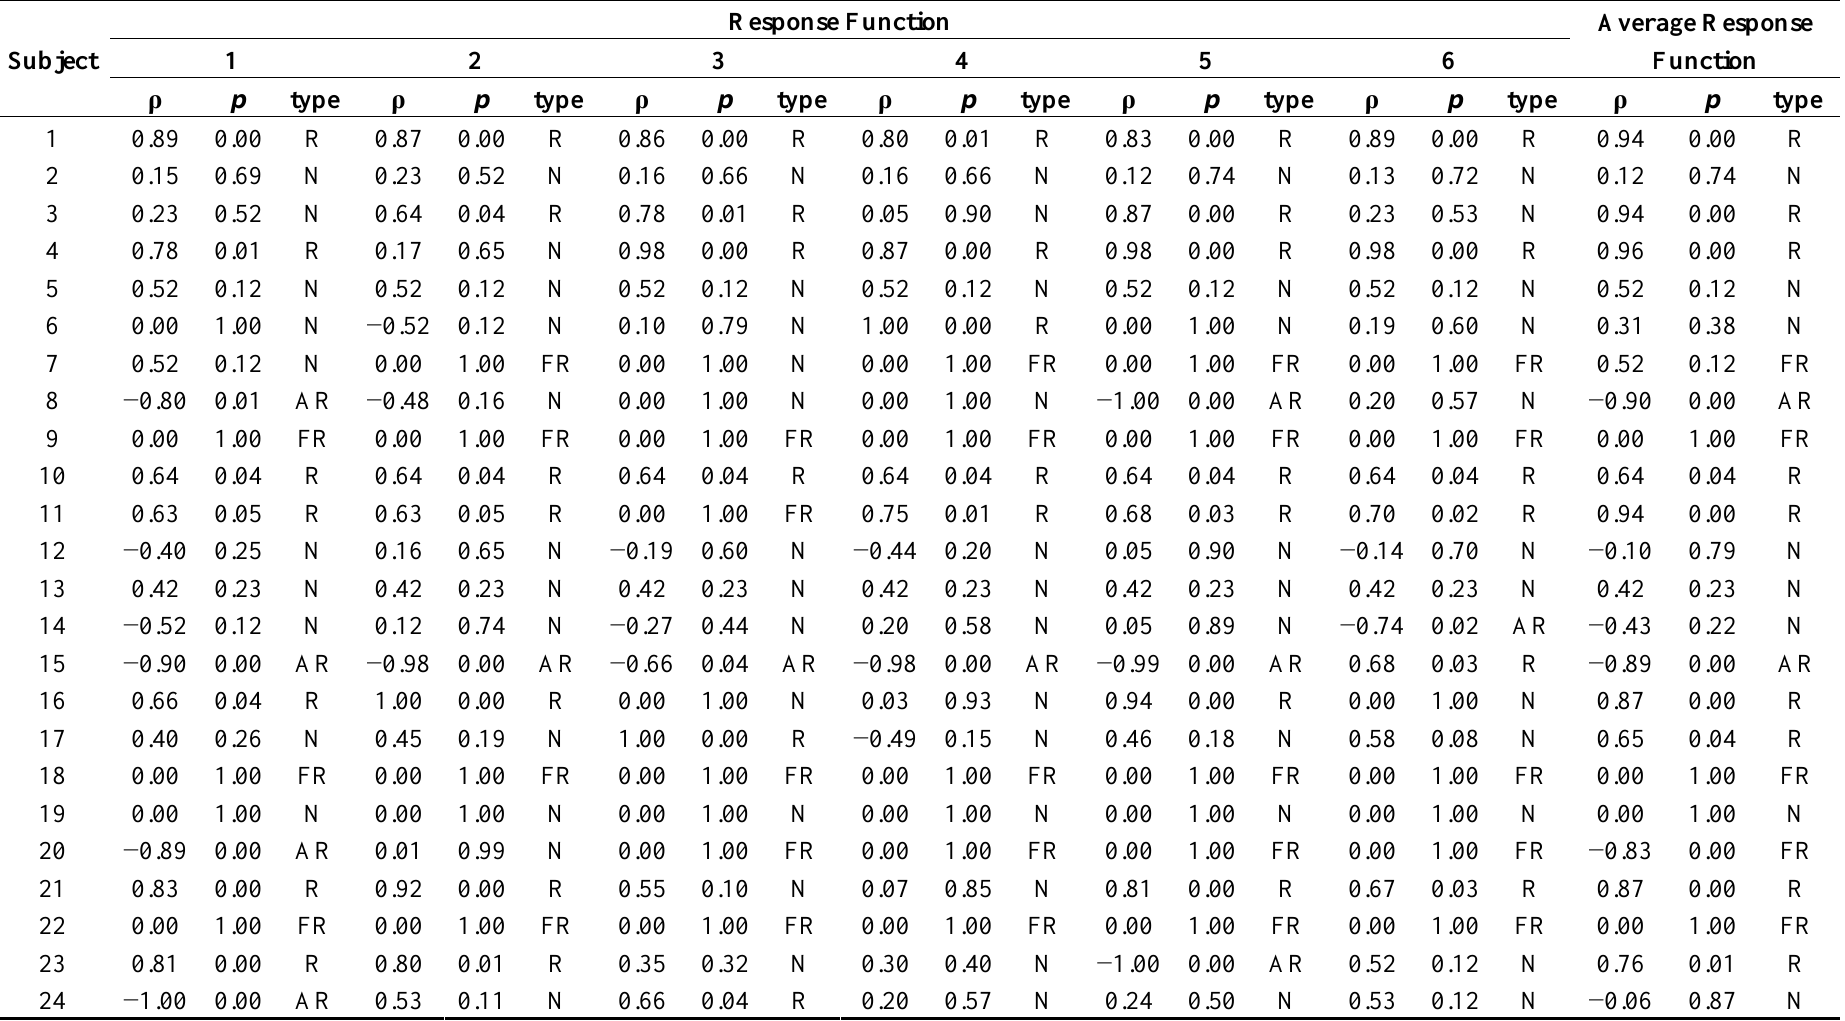
Table A1. Characterization of the 192 response